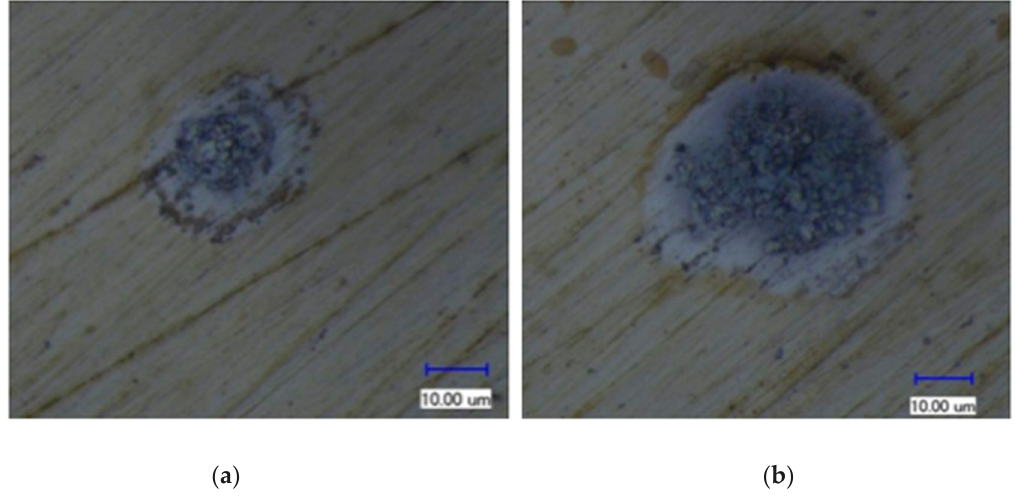
Figure 9. Surface morphology of a discharge crater when the workpiece was connected to a negative electrode: ( a ) the discharge duration was 0.85 μ s and ( b ) the discharge duration was 9 μ s.